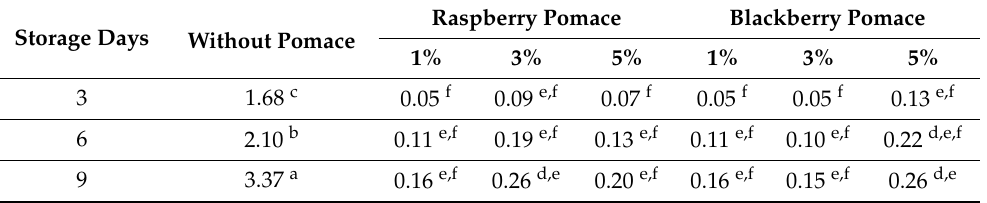
Table 2. Natural mass loss of beef patties stored for nine days, %.